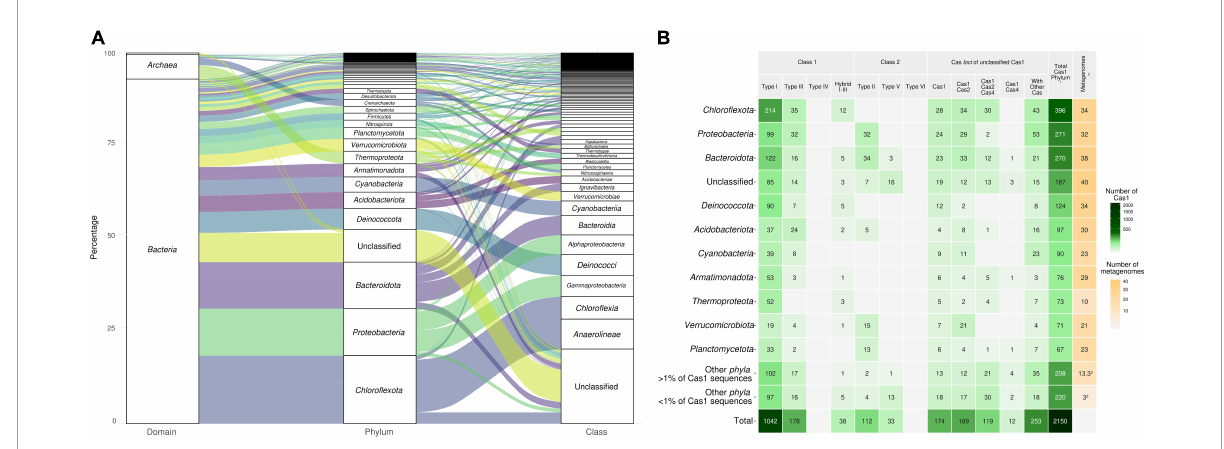
FIGURE2 (A) Taxonomic distribution at the domain, phylum, and class level of Cas1 proteins from 48 globally distributed metagenome data sets (sequences over 1% are represented). Detailed taxonomic affiliation, metadata, and the aminoacidic sequence of each Cas1 protein used here can be retrieved in Supplementary Table 3 . (B) Typification of the 2,150 Cas1 used in this study according to CRISPR-Cas system class and type. 1 Number of Cas1 proteins at the phylum level, including the unclassified category. 2 Number of different metagenome samples that harbor members of each phylum. 3 Average of samples where those phyla are